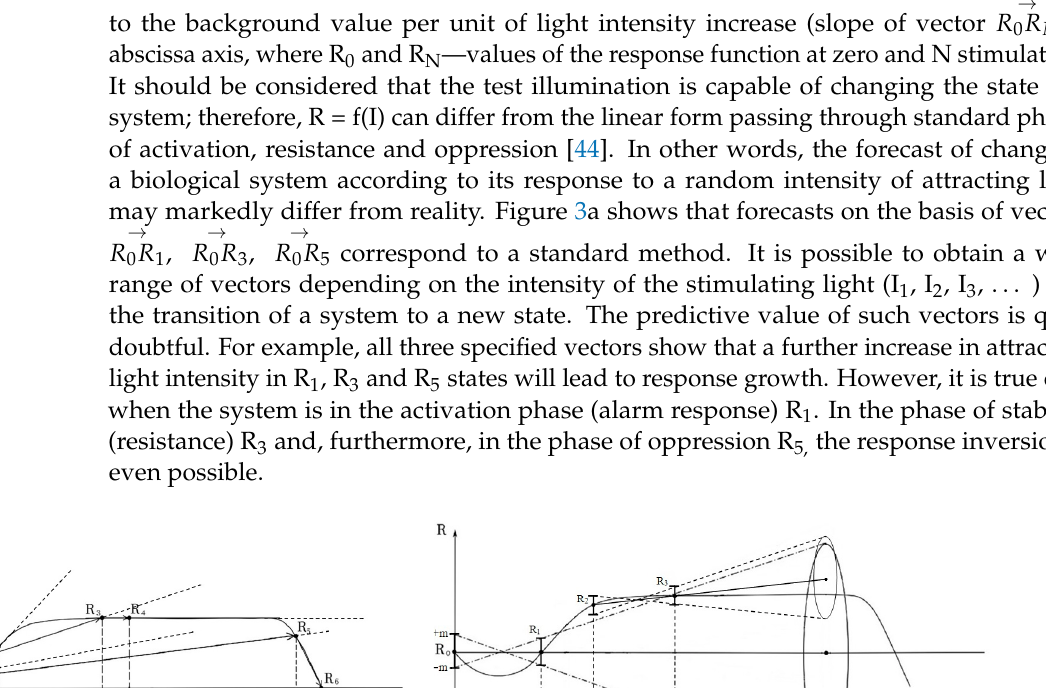
6 of 22 Figure 2. DHC-based laboratory unit and ( a ) photo of light columns with hydrobionts ( b ): ( a ): 1—DHC, 2—DHC recording unit, 3—DHC lighting module, 4—laboratory water tank, 5—test (working) volume formed by recording (red) and attracting (green) light beams, 6—mirror-prism system for working volume forming, 7—semiconductor laser diode ( λ = 650 nm), 8—semiconductor laser diode ( λ = 532 nm), 9—fiber-optic multiplexer (mixer), 10—beam expand- er, 11—windows, 12—selective filter, 13—receiving lens, 14—CMOS camera. The images of 400 layers of the studied volume with a thickness of 1.7 mm were sequentially and automatically reconstructed from each registered digital hologram of the measured volume, thusly calculating the number of crustaceans layer-by-layer using the DHC. 2.4. Paired Photostimulation of Behavioral Response to Assess the Responsiveness of Planktonic Communities The use of the phototropic behavioral response of mesoplankton as the indicator of